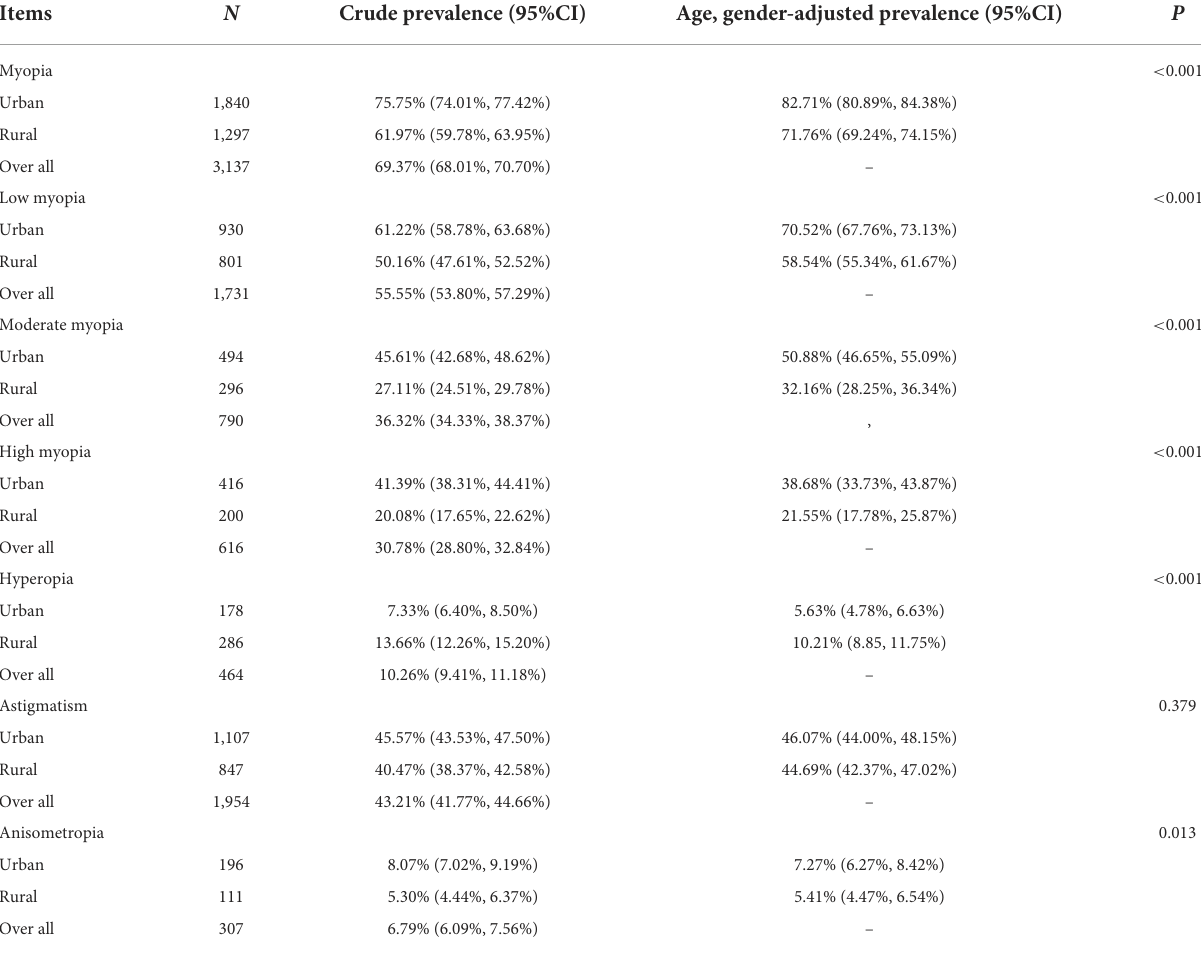
TABLE 2 Crude and age-adjusted prevalence of different refractive